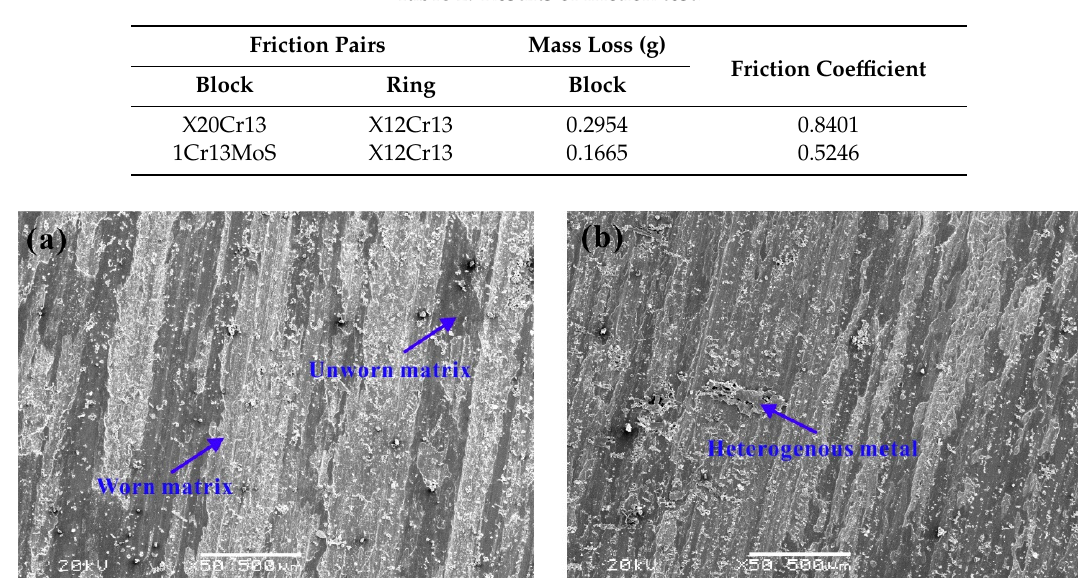
Figure 9. Morphology of blocks after friction test obtained by SEM (Secondary electrons, Acceleration voltage: 20 kV, Working distance: 10.0 mm), ( a ) X20Cr13, ( b ) 1Cr13MoS. voltage: 20 kV, Working distance: 10.0 mm), ( a ) X20Cr13, ( b )